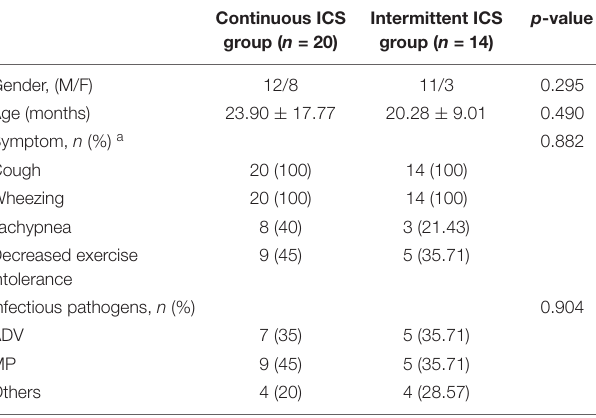
TABLE 1 | Comparison of clinical data between continuous ICS group and intermittent ICS group at diagnosis of PIBO.